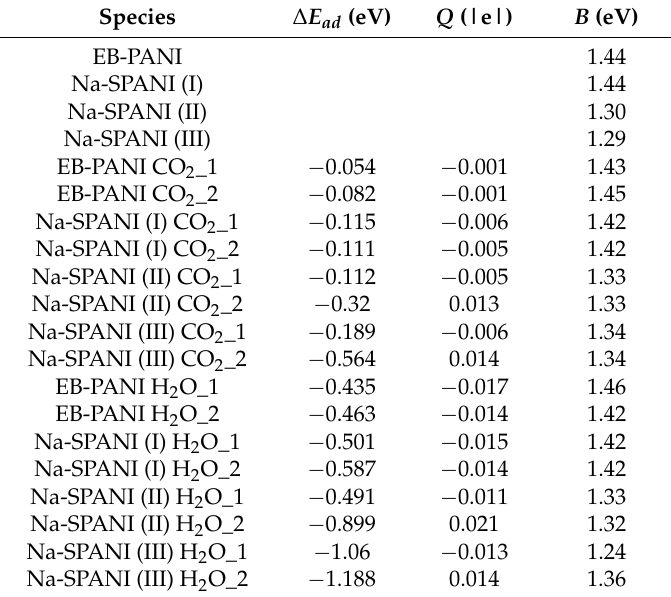
Table 2. Adsorption energy ( ∆ E ad ), charge transfer ( Q ) and band gap ( B ) of H 2 O and CO 2 molecules on polymers.